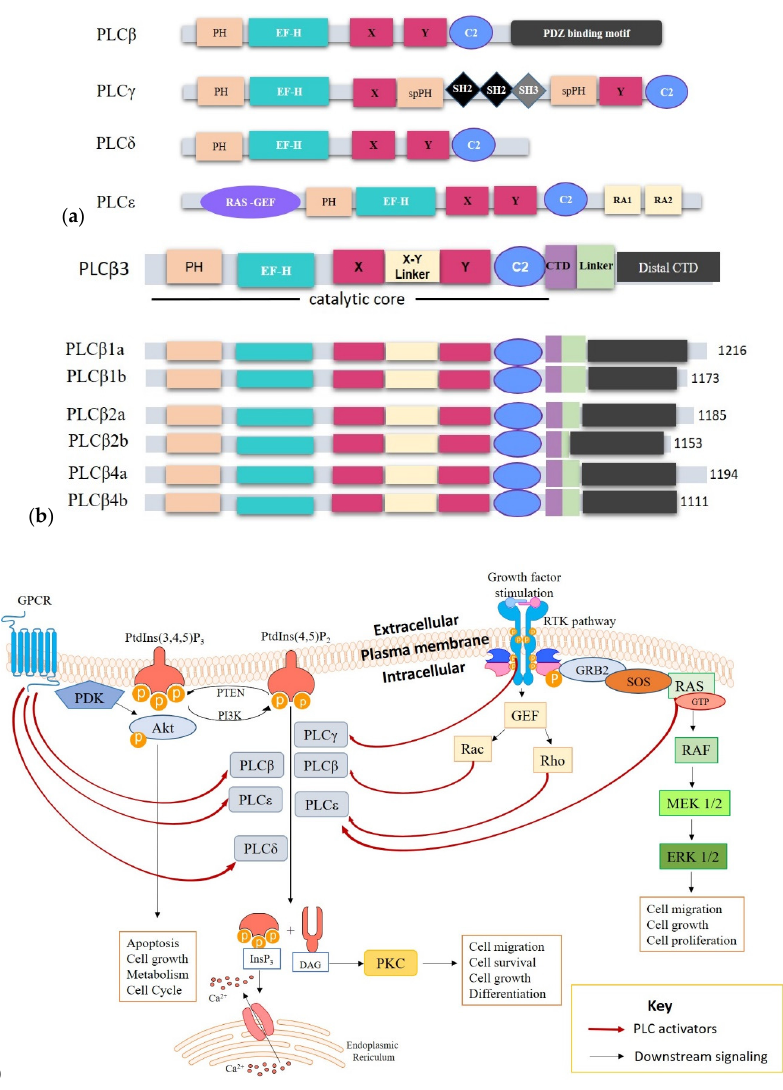
Figure 2. The structure and activation of phospholipase C (PLC) isozymes. ( a ): cartoon